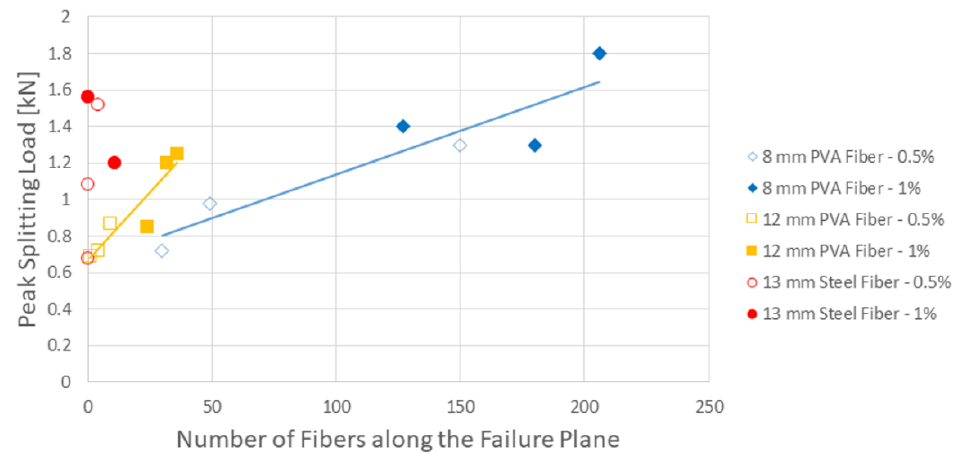
Figure 11. Peak splitting load versus number of fibers along the failure plane after substrate-repair splitting.